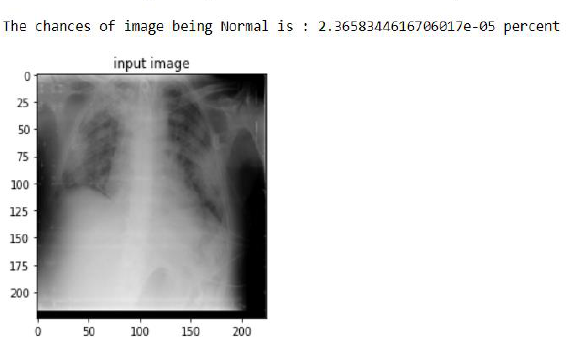
Figure 4.3: Simulation of Model with sample image